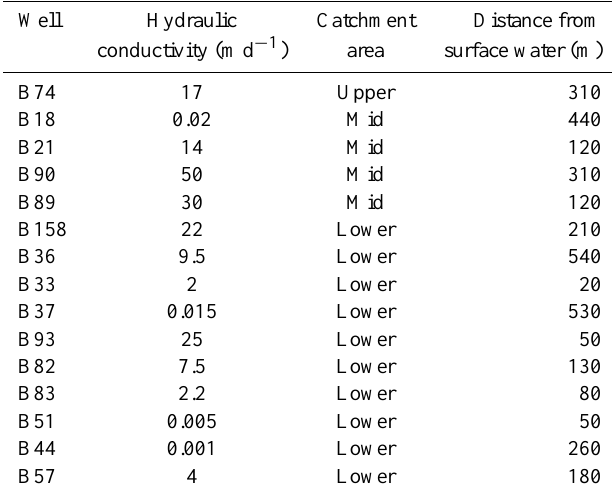
Table 2. Hydraulic conductivities from falling/rising head tests in the alluvium of the Cressbrook Creek